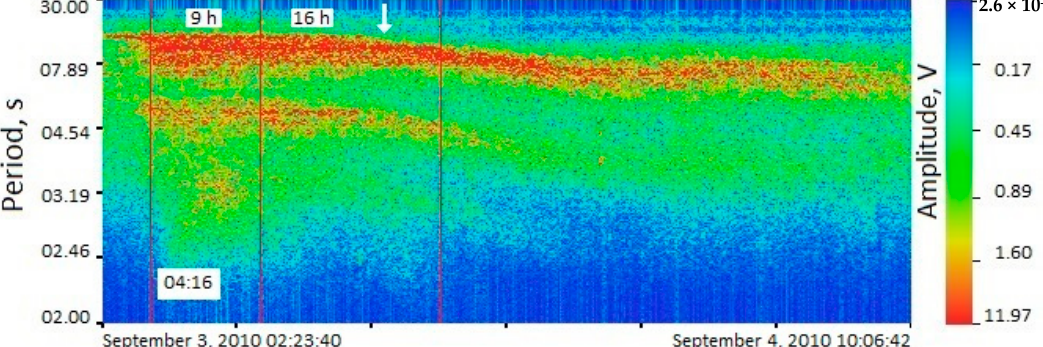
Figure 7. Segments of swell waves arrival time from points 3 and 4 of the typhoon trajectory.